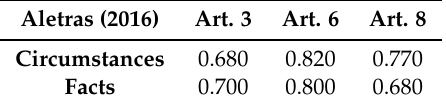
Table 2. English accuracy baselines on facts and circumstances from the literature.